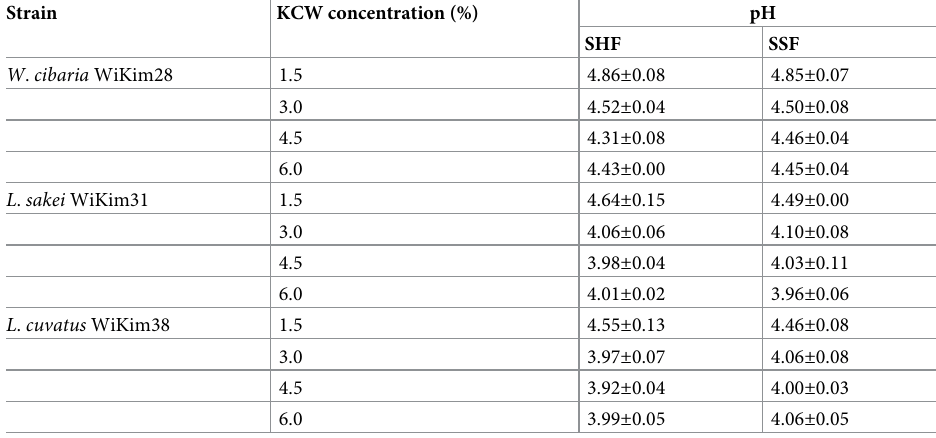
Table 3. Final pH value after SHF and SSF processes for 144 h.